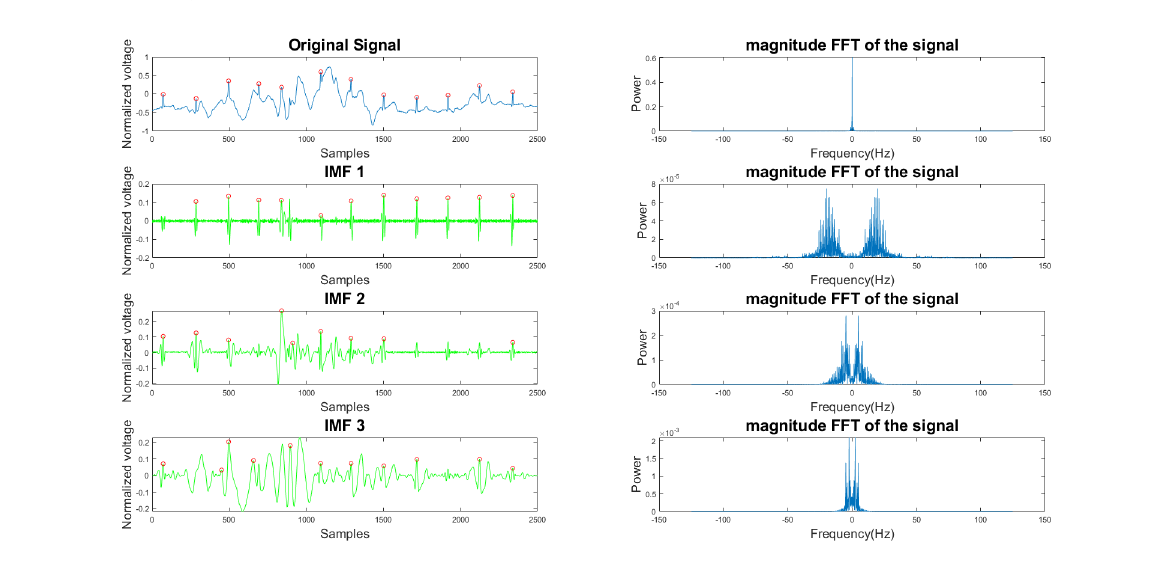
Figure 5. Time and frequency form of a usable ECG signal and its